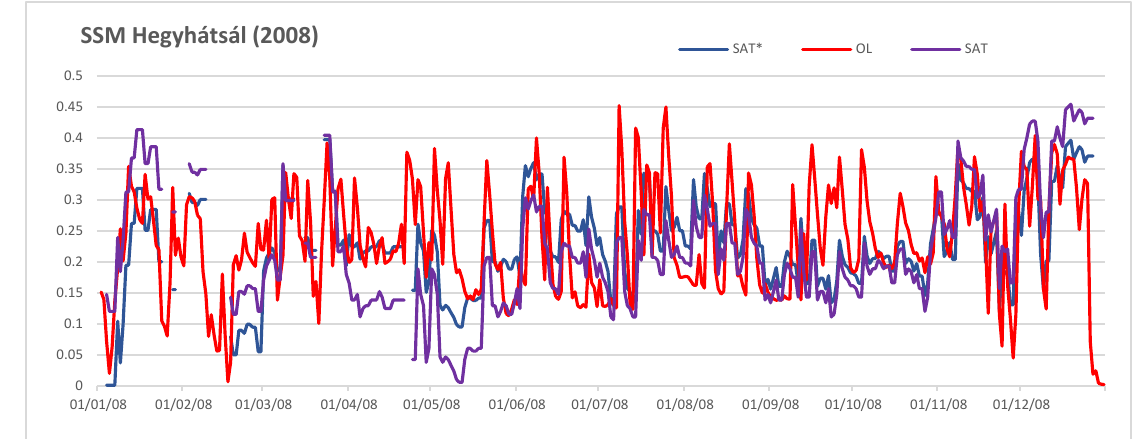
Figure 1. Raw ( a ) and extrapolated ( b ) GEOV1 Leaf area index from the Copernicus Global Land Service project on 13 April 2008.